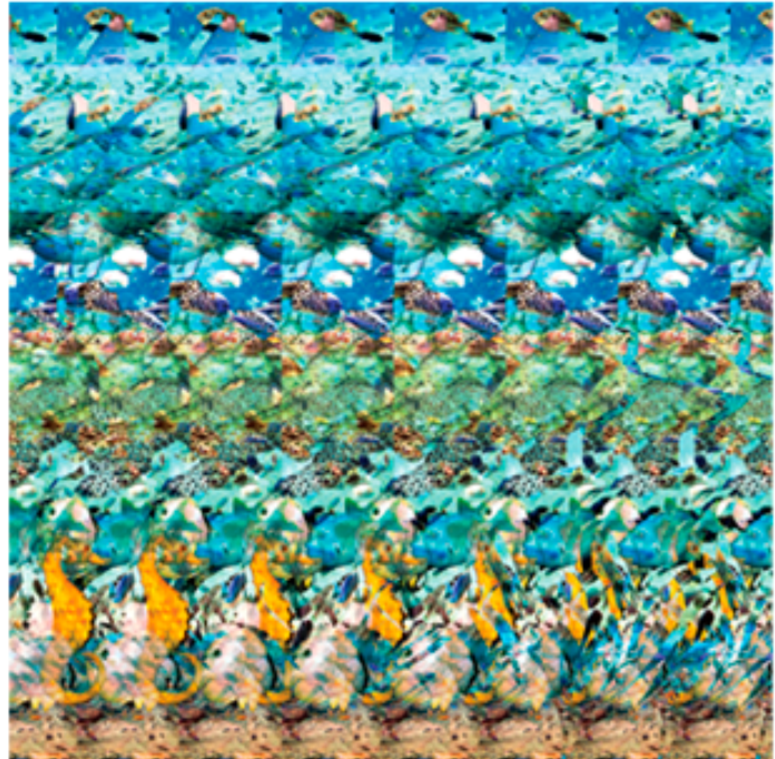
Picture 1: “Behind” this colorful ornament, there is a 3-D picture of the sea world: https://www.magiceye.com/ Although one can learn how to diverge their eyes, the successful divergence from the 2-D ornament